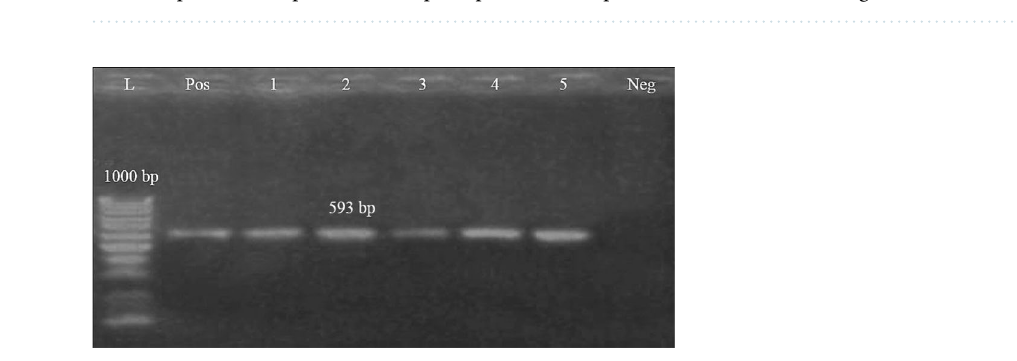
Figure 8. Electrophoretic pattern of primers targeting tet A gene. Lane L: 100 bp molecular weight ladder (Fermentas, Thermo Scientific, Germany); lane Pos: the positive control (Reference strain from Animal Health Research Institute in Dokki, Cairo, Egypt), and lane Neg: the negative control (template without DNA). Lanes 1–7: the specific DNA product (576 bp) amplified from representative strains of P. aeruginosa .